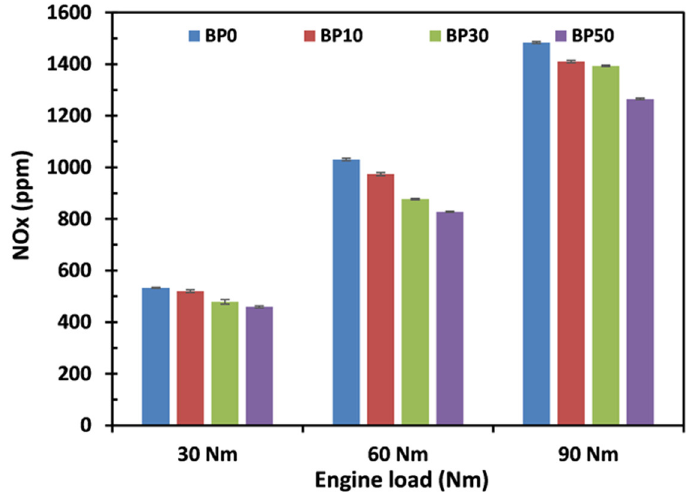
Figure 10. NOx emissions for all test fuels according to various engine